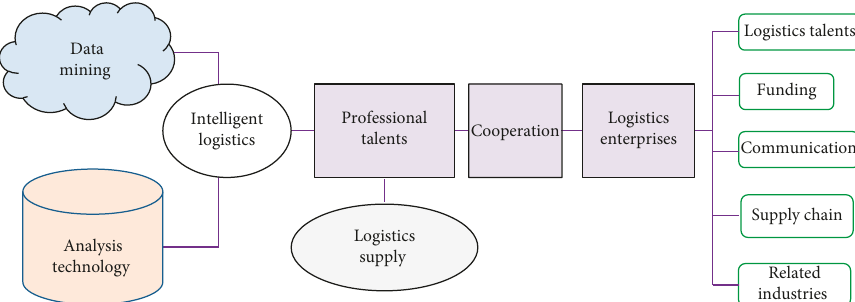
Figure 5: Wireframe of capital investment, talent training, and research of data mining and analysis